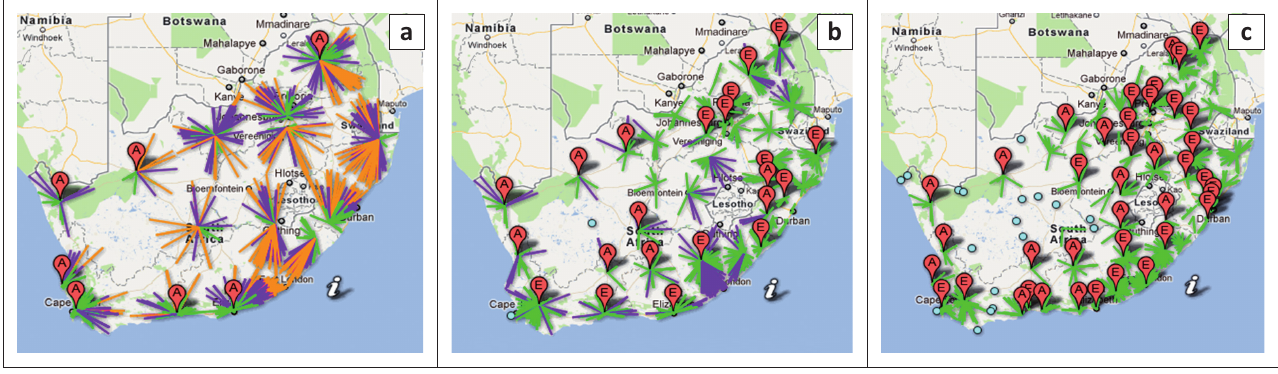
TABLE 1: Number of CD4 laboratories and point-of-care sites for scenarios A, B and C. Scenario